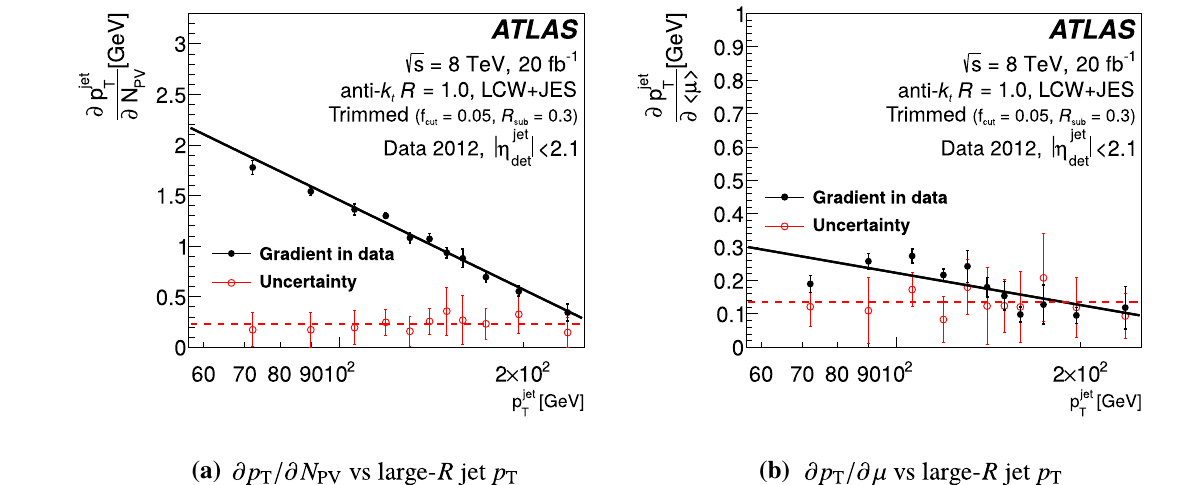
Fig. 32 The gradients a ∂ p T /∂ N PV and b ∂ p T /∂μ extracted in γ +jet data (filled circles) and the difference of the gradients measured in data and MC simulations (empty circles) as functions of the large- R calorimeterjet p T .Thelinescorrespondtofitsofaconstanttotheuncer-